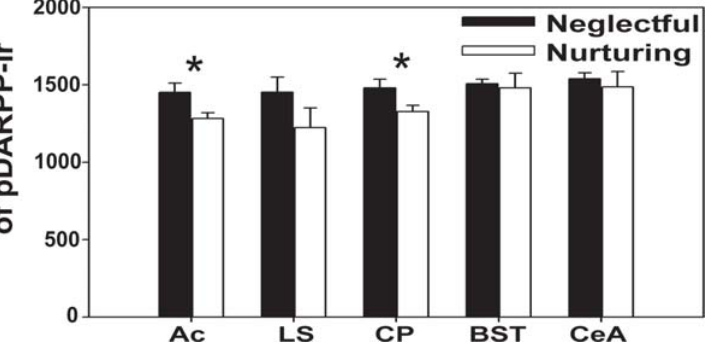
Figure 7. Altered pDARPP-32 expression with maternal neglect. Previously neglectful dams (N=5) have significantly darker optical density of pDARPP-32 expression in Ac and CP when compared to previously nurturing dams (N=6). Ac=nucleus accumbens, LS=lateral septum, CP=caudate-putamen, BST=bed nucleus of stria terminalis, dorsal, CeA=central amygdala. Bars represent means 6 SE. * =p , 0.05.